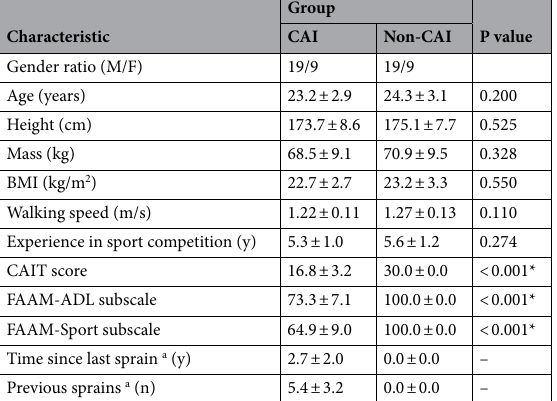
Table 1. Participant characteristics (Mean ± SD). CAI Chronic ankle instability, CAIT Cumberland ankle instability Tool, FAAM-ADL Foot and ankle ability measure-activities of daily. *Denotes a significant difference. a Indicates subjectively reported variable.